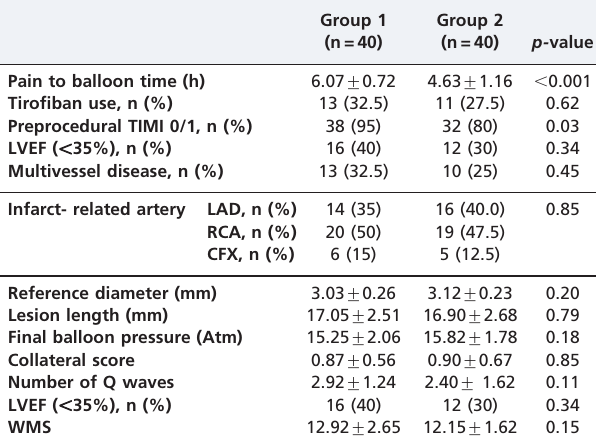
Table 3 - Angiographic, echocardiographic, and electrocardiographic characteristics of the